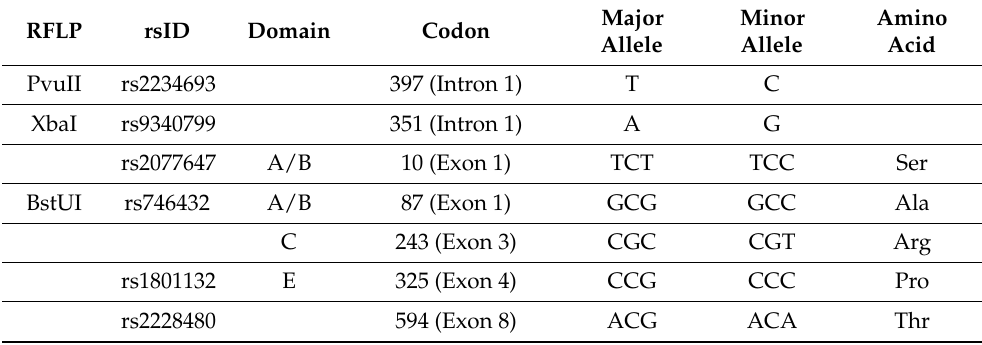
Table 3. Main polymorphisms of the ER α gene ( ESR1 ) investigated in association studies. The major allele was selected in agreement with the single nucleotide polymorphism database dbSNP. (RFLP: restriction fragment length